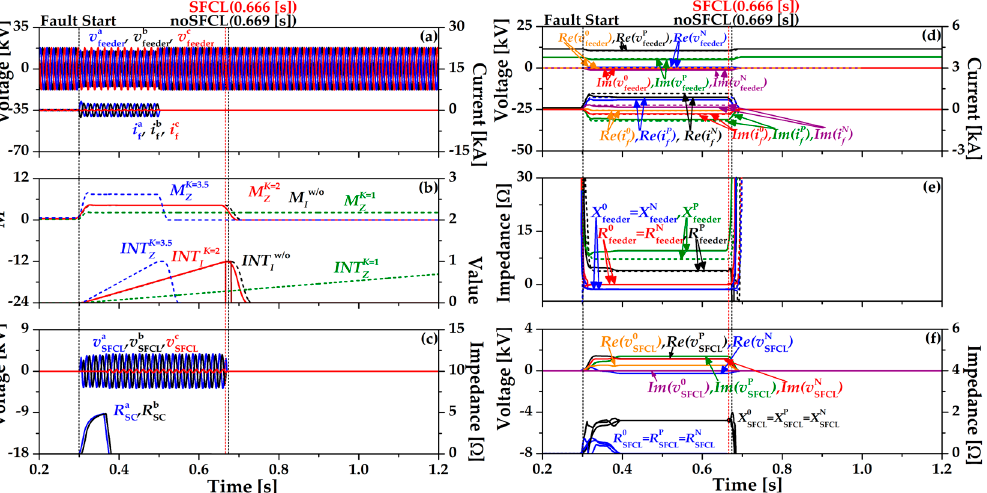
Figure 7. Waveforms and signals of OCR using M I , M Z in DLG. ( a ) Three phase feeder voltage ( v feeder ), current ( i f ). ( b ) Index of CB ( M I , M Z ) and signal of OCR ( INT I , INT Z ). ( c ) Three phase SFCL voltage ( v SFCL ), HTSC element ( R aSC , R bSC ). ( d ) Sequence feeder voltages ( v 0 feeder , v Pfeeder , v Nfeeder ), sequence feeder currents ( i 0 f , i Pf , i Nf ). ( e ) Sequence feeder impedances ( R 0 feeder , R Pfeeder , R Nfeeder , X 0 feeder , X Pfeeder , X Nfeeder ). ( f ) Sequence SFCL voltages ( v 0 SFCL , v PSFCL , v NSFCL ) and sequence SFCL impedances ( R 0 SFCL , R PSFCL , R N SFCL , X 0 SFCL , X PSFCL , X NSFCL ).